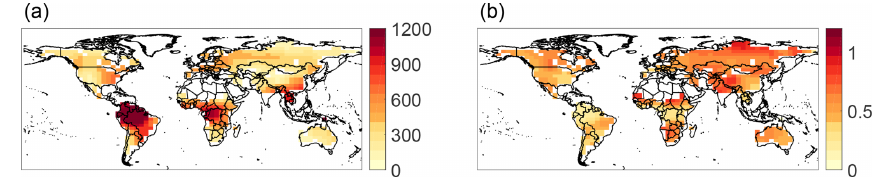
Figure 3. Spatial variability in top-down R h . Maps of (a) mean R h (gCm 2 yr − 1 ) and (b) temporal coefficient of variation in top-down R h , calculated based on monthly data over